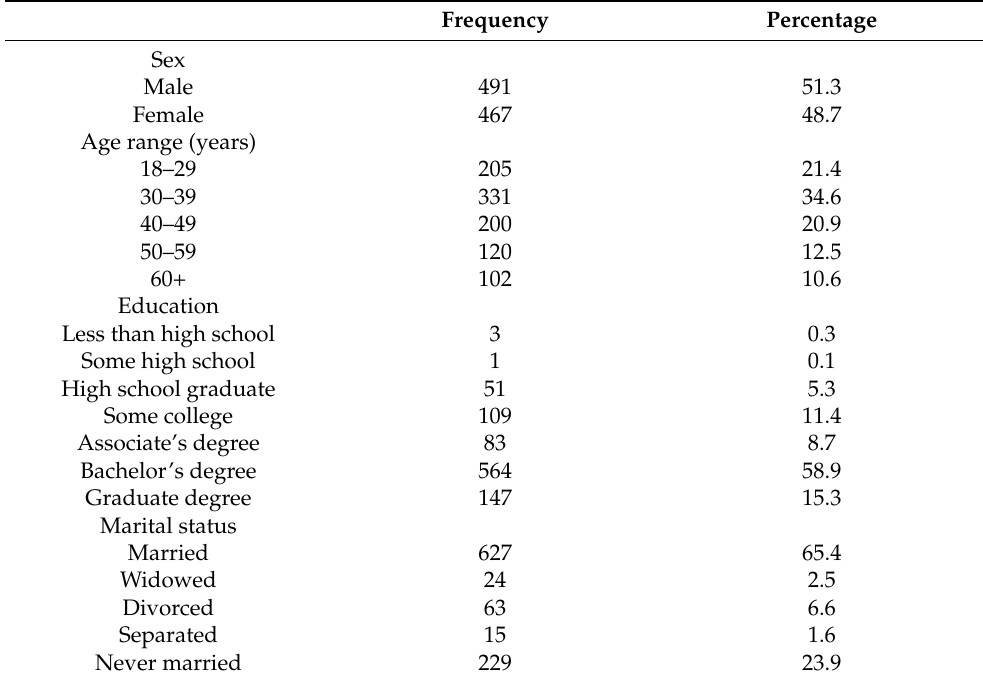
Table 1. Demographic characteristics of US adults who completed the COVID-19 and Lifestyle Questionnaire ( n = 958).